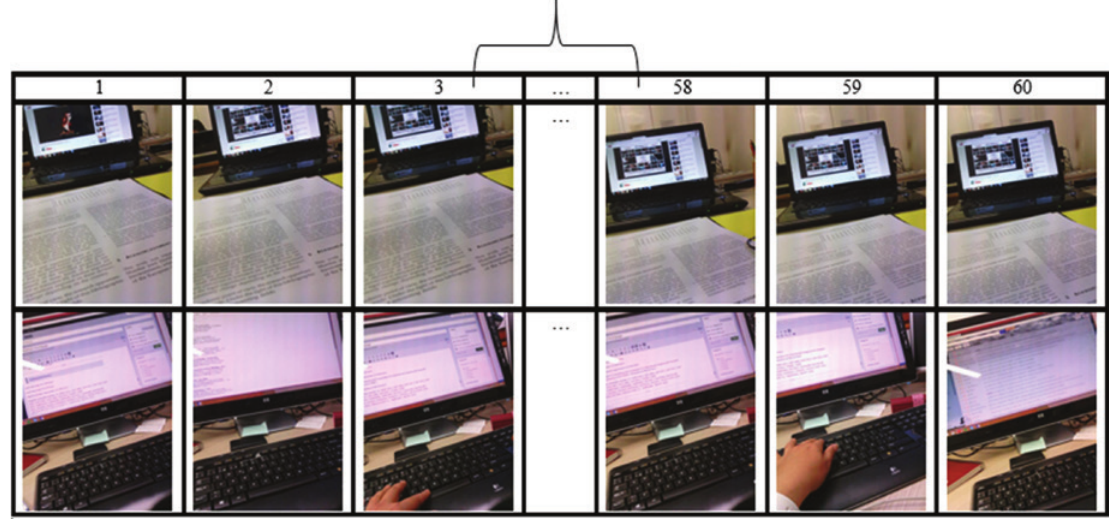
Figure 6: Short example of similarity between days 6 and